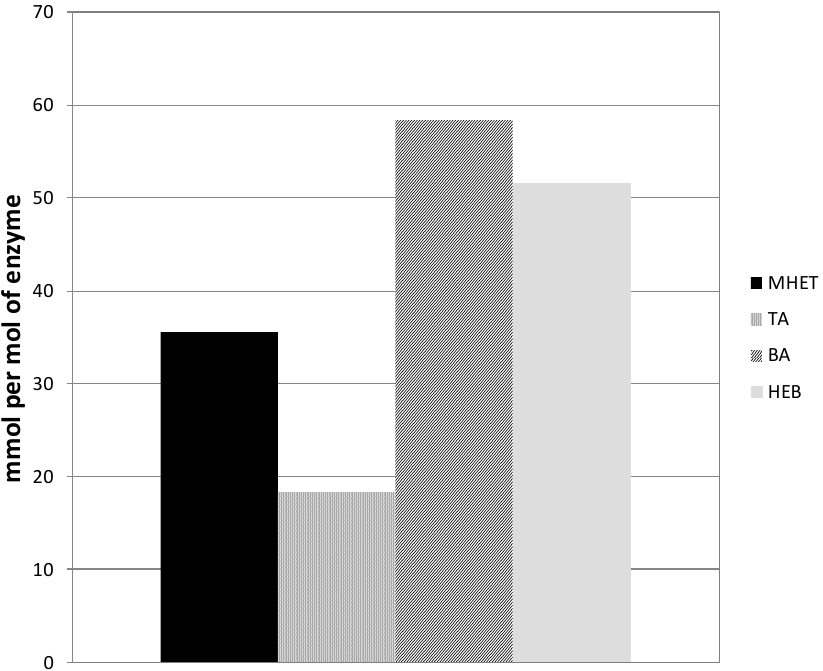
Figure 3. Hydrolysis of the PET model substrate 3PET with the esterase